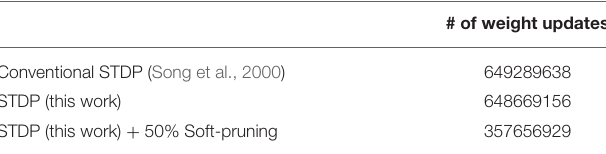
TABLE 2 | The number of weight updates of conventional STDP ( Song et al., 2000 ), STDP used in this work with and without 50%